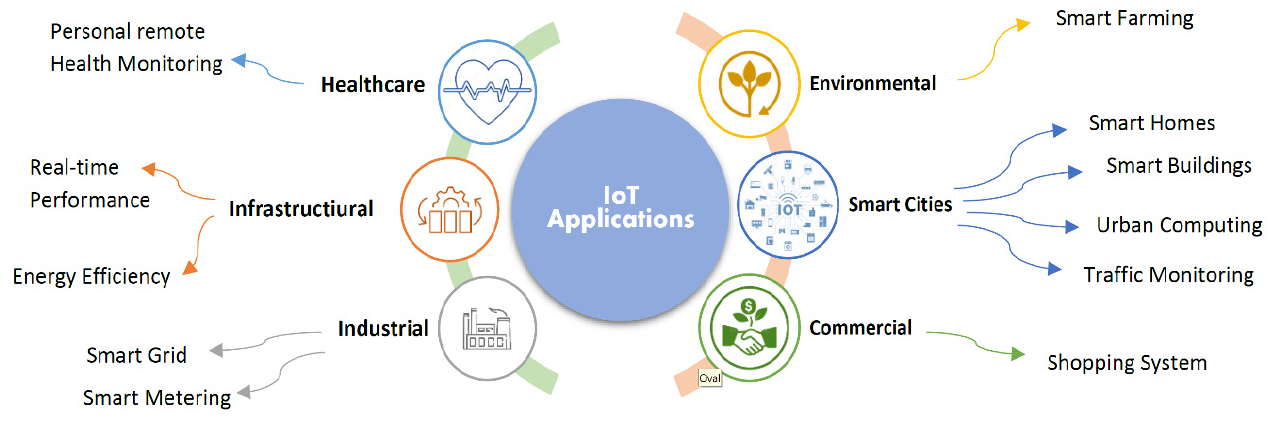
Figure 3. Study selection of the real-time scheduling in IoT.